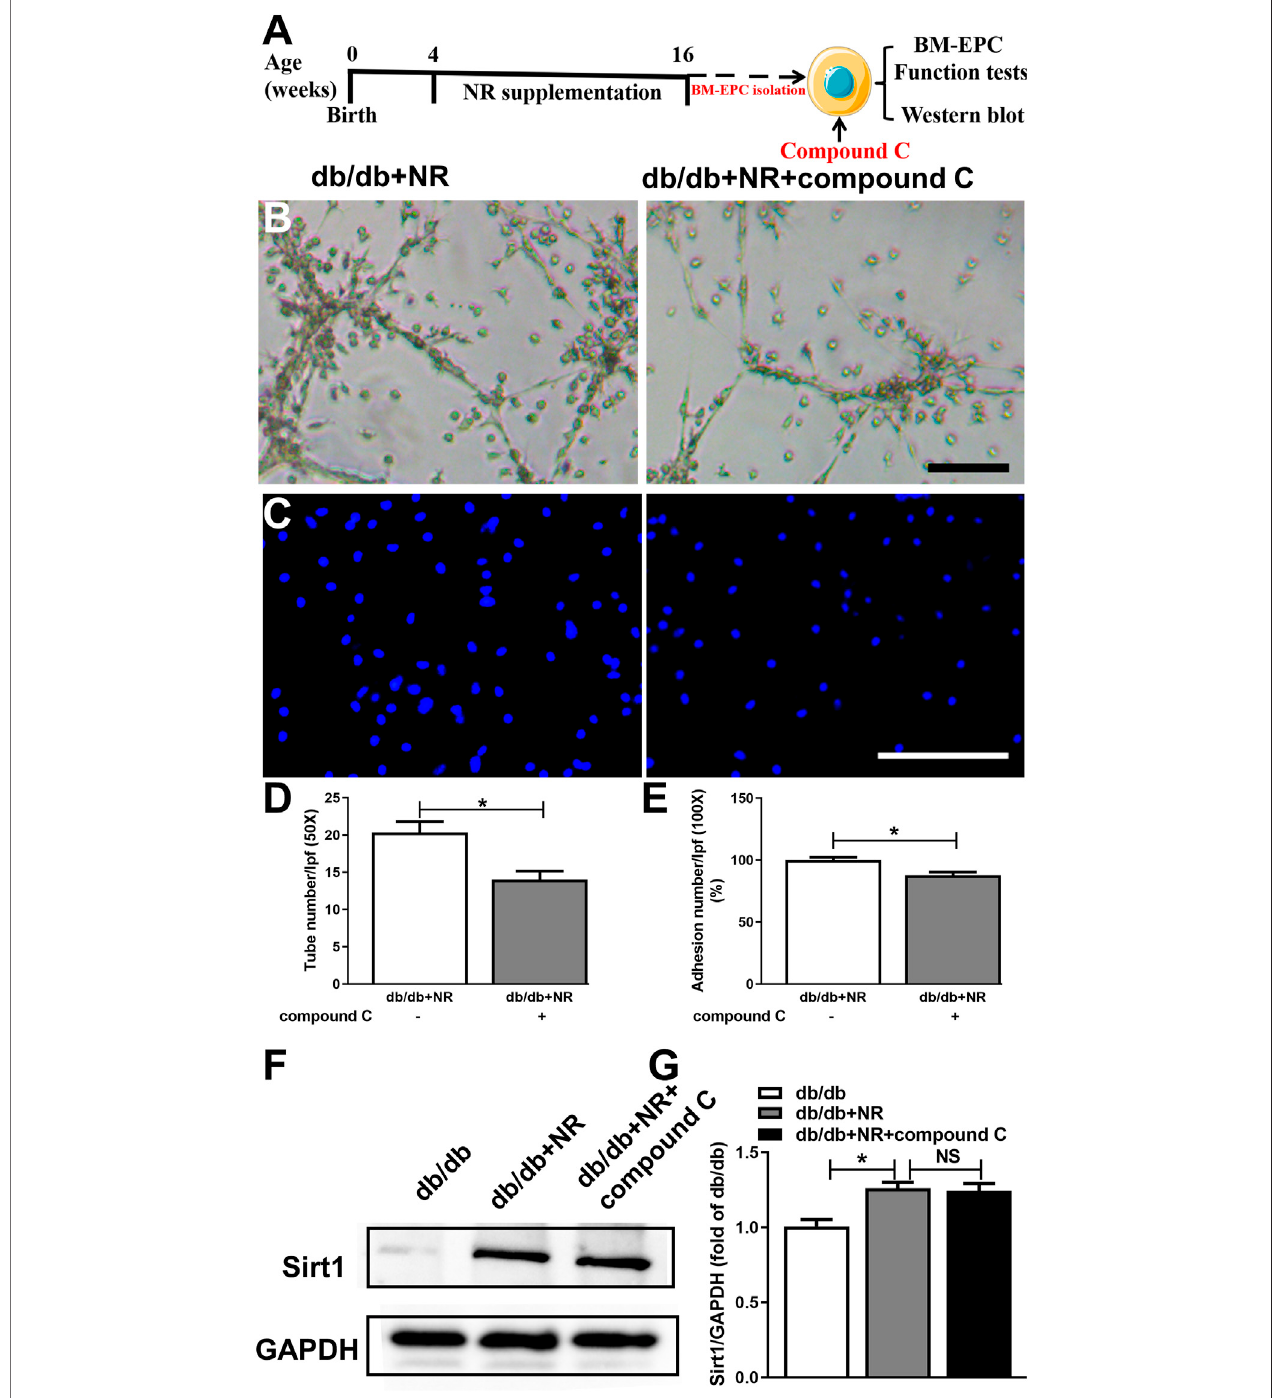
FIGURE 6 | Inhibition of AMPK with compound C abolished the protective effects of NR supplement on BM-EPC function in db/db mice. (A) Illustration of experimental protocol. Db/db mice treated with NR for 12 weeks, and then, BM-EPCs were isolated and stimulated with compound C (10 μ M). Tube formation (B) and adhesion (C) assay in BM-EPCs treated with NR in the presence or absence of compound C. Quantitated analysis of tube number (D) and adhesion number (E) . (F – G) Compound C has no signi fi cant effect on Sirt1 expression in BM-EPCs of db/db mice treated with NR. B: 50 × ; scale bar, 100 μ m; C: 100 × ; scale bar, 100 μ m. Values are mean ± SEM ( n (cid:2) 3). * P < 0.05. BM-EPC, bone marrow – derived endothelial precursor cell; NS, no signi fi cance.